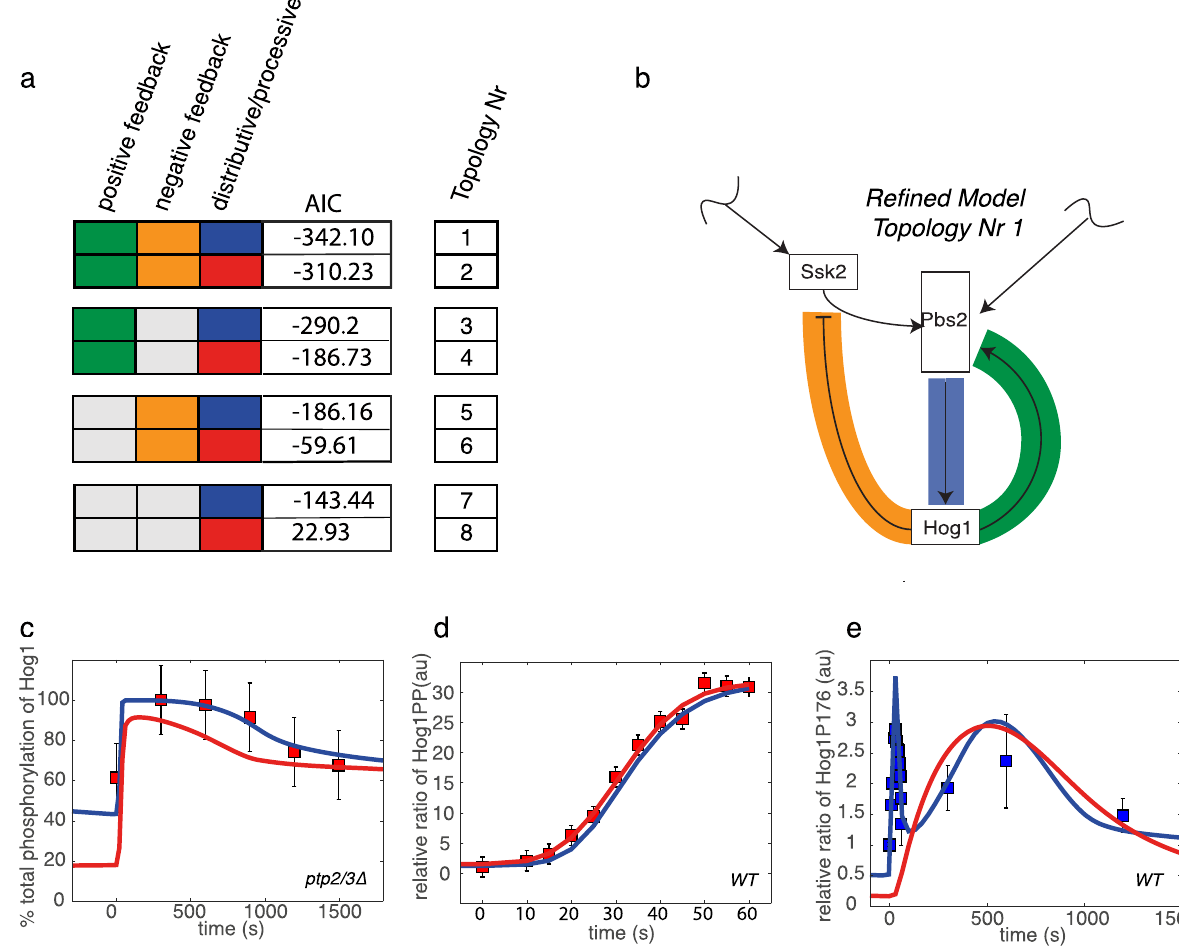
Fig. 2 | Re fi ned model employs negative and positive feedback and favors a distributive over a processive phosphorylation mechanism. a Eight different topologies were enumerated with different combinations of negative feedback (orange),positivefeedback(green)anddistributive(blue)orprocessive(red)Hog1 phosphorylation mechanism. Akaike Information Criterion (AIC)of the best model fi ts are displayed. b Scheme of re fi ned model (according to pipeline described in Fig. 1c) with topology one. Negative feedback on Ssk2 and positive feedback on Pbs2 are indicated in orange and green respectively. The distributive phosphor- ylation mechanism of Hog1 by Pbs2 is visualized in blue. Simulations of selected species of the two best- fi tting models employing distributive or processive Hog1 phosphorylation (Topology Nr 1 and 2) are shown in response to salt stimulation (0.4M NaCl). Graphs show experimental data points used for parameter optimi- zation (red square), experimental data points used for testing (blue square), simulation results from the best- fi tting distributive mechanism (blue) and